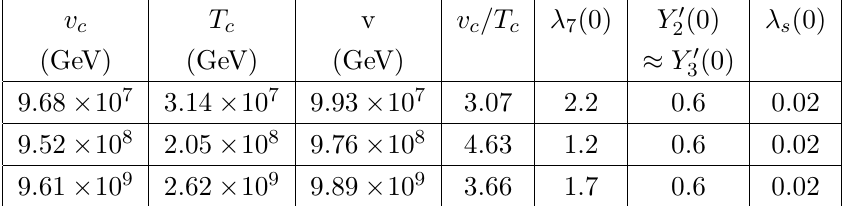
Table 5 . Benchmark parameters and other details for high scale leptogenesis scenario. (cid:15) N